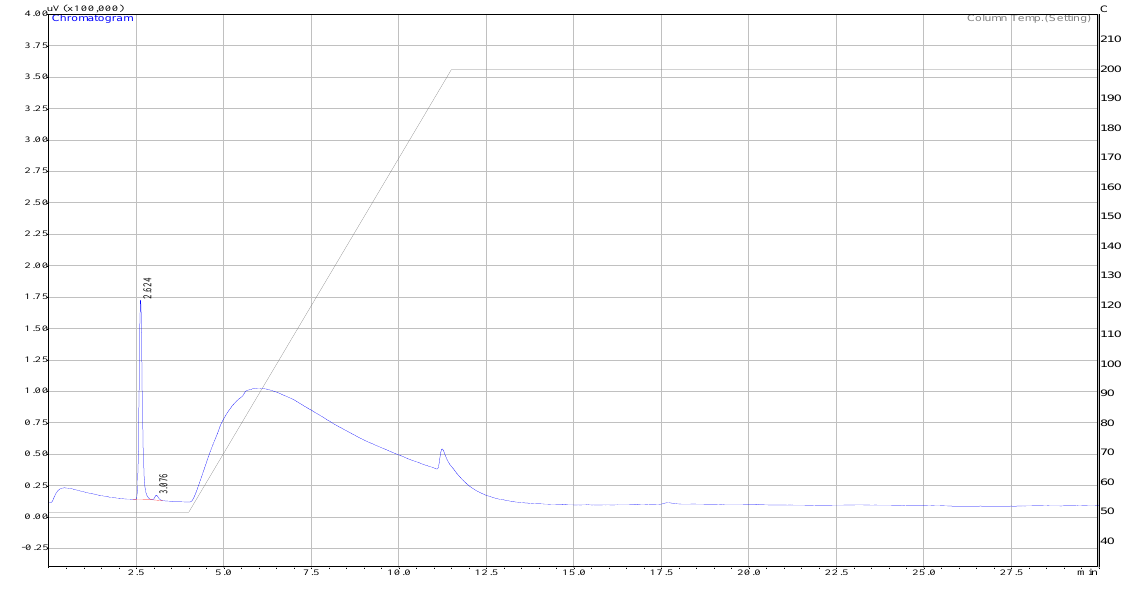
Figure A2. Hydrogen peak as detected by the TCD.